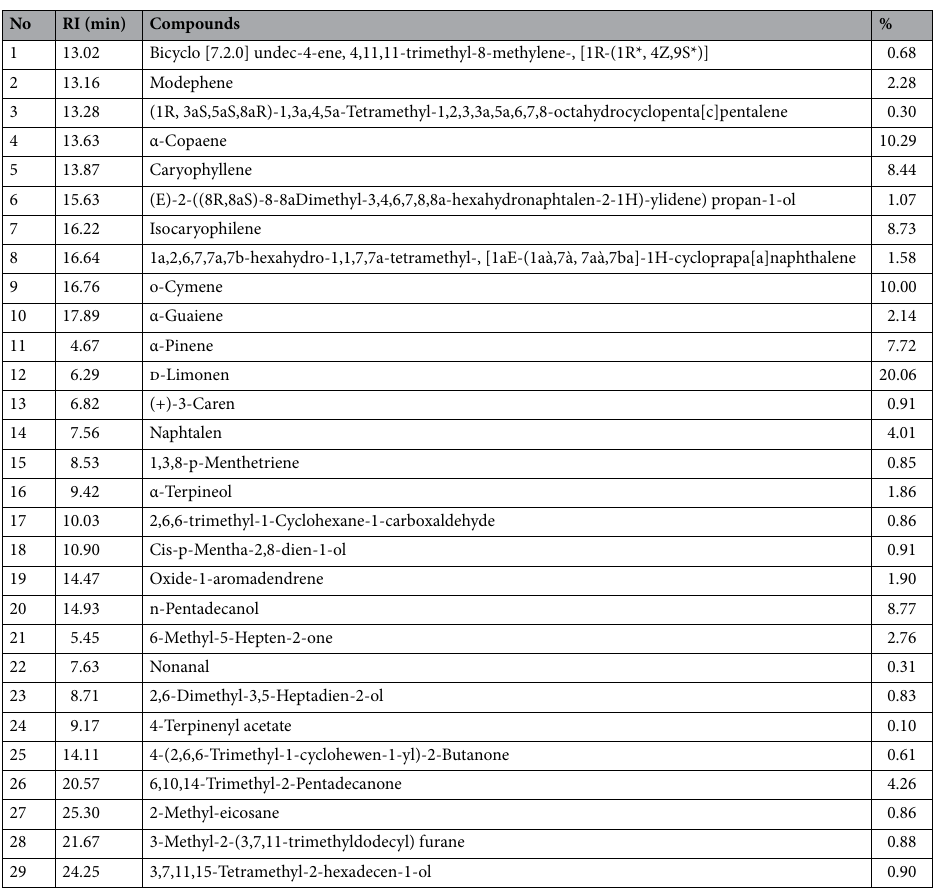
Table 1. Chemical composition of the T. diversifolia essential oil. The table represents information on the chemical composition of the T. diversifolia essential oil. RI: retention index; A number was used to differentiate between Sesquiterpernes (1 to 10), Monoterpenes (11 to 20), Phenylbutane derivatives (21 to 27) and the Diterpenes (28 and 29). Percentage of each compound is presented in the last